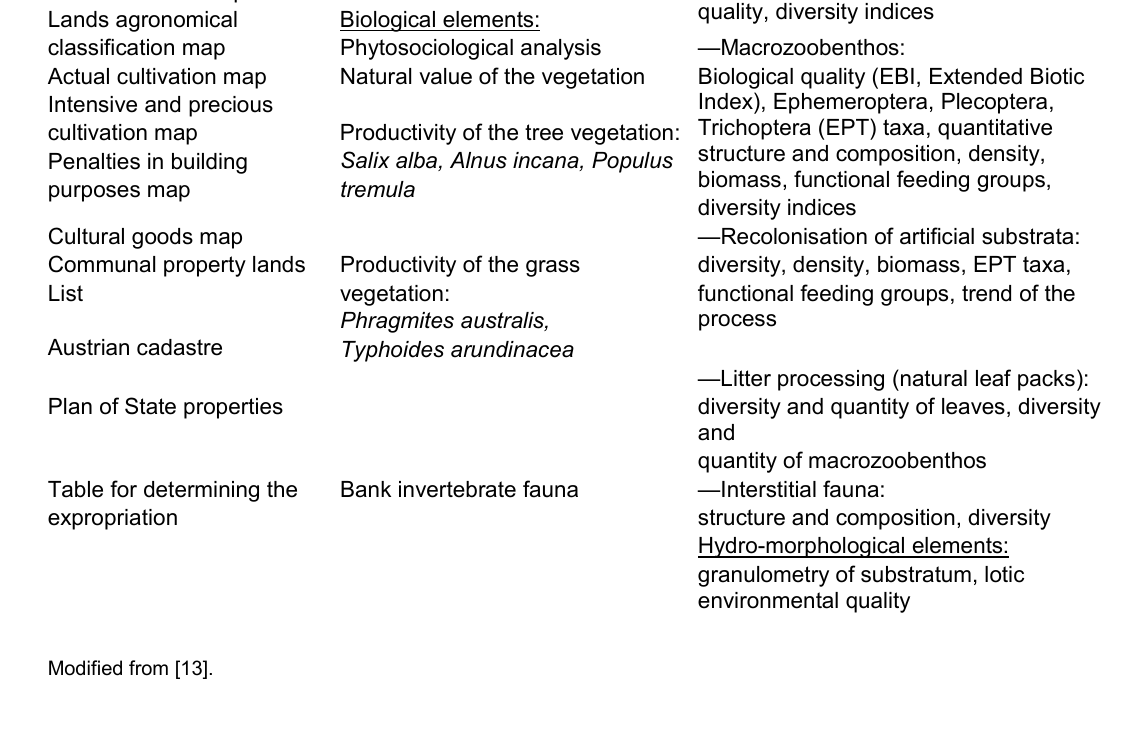
structure and composition, diversity Hydro-morphological elements: granulometry of substratum, lotic environmental quality